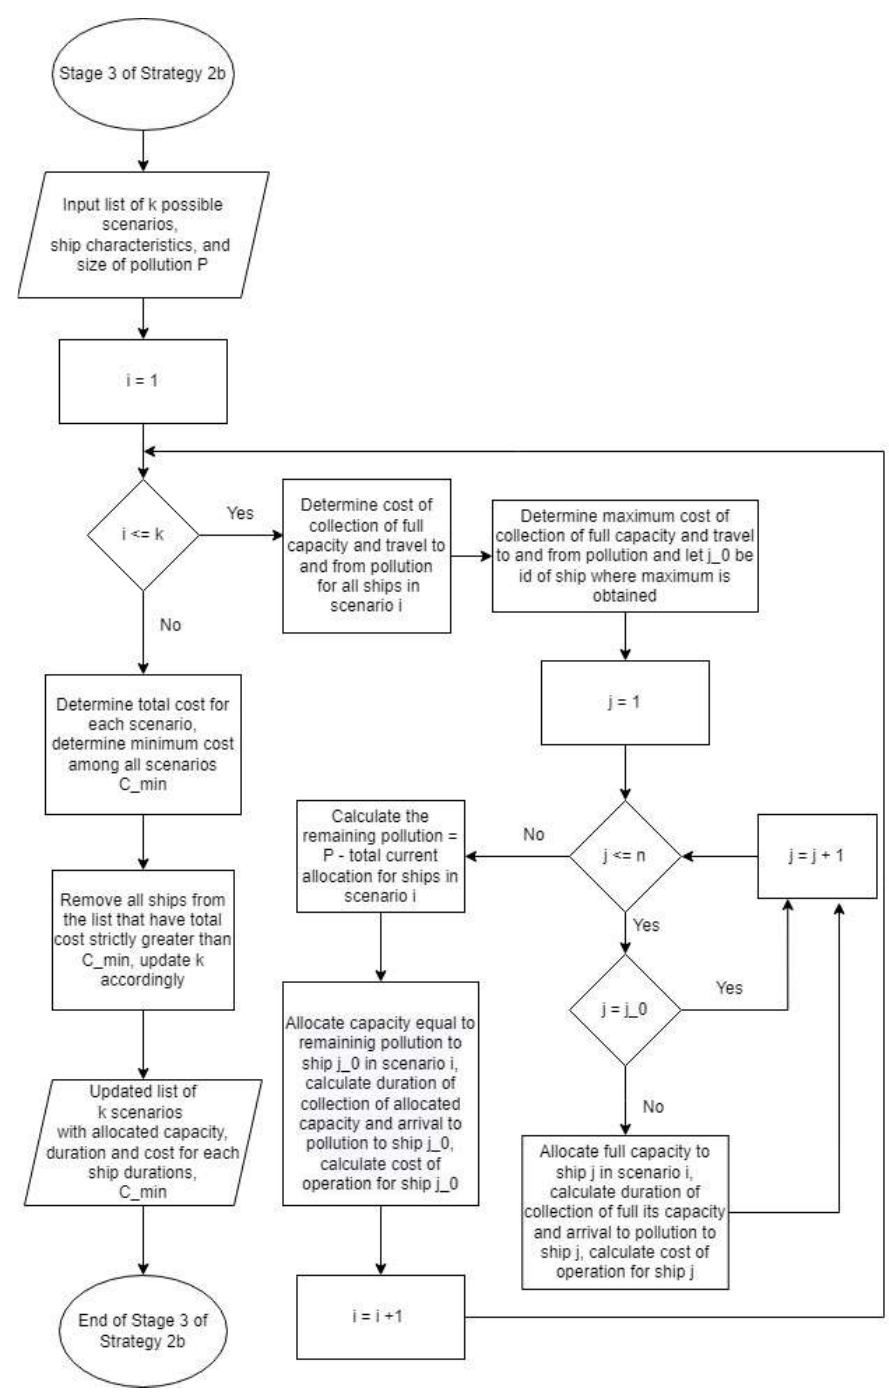
Figure 13. Flowchart for Stage 3 of Strategy 2b.